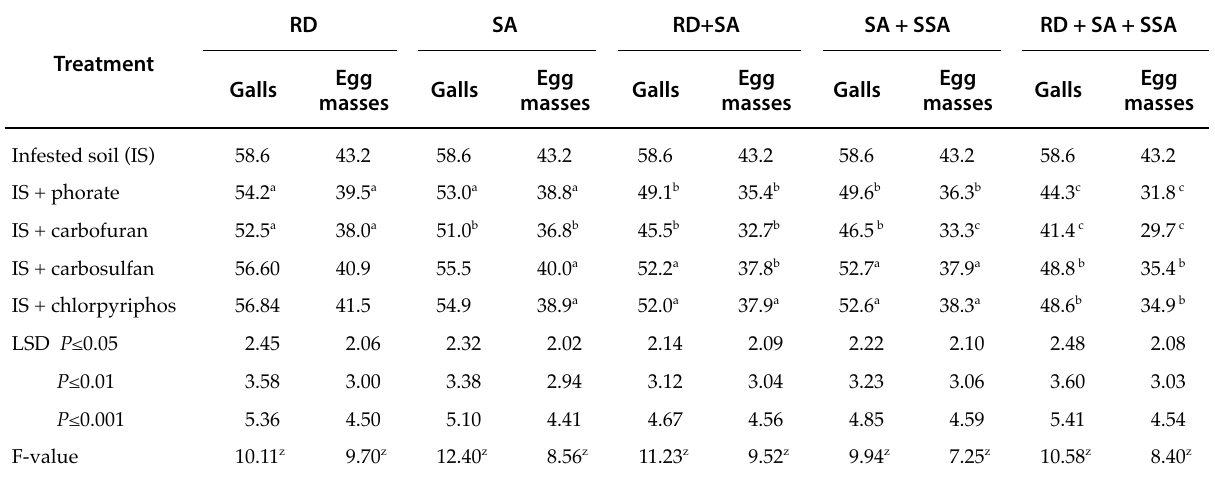
Table 1. Mean numbers of Meloidogyne graminicola galls and egg masses on rice plants to which different nematicide treat - ments were applied. RD, Root Dip; SA, Soil Application 15 days after transplanting; SSA, Second Soil Application 30 days after transplanting. Each value is mean of ten